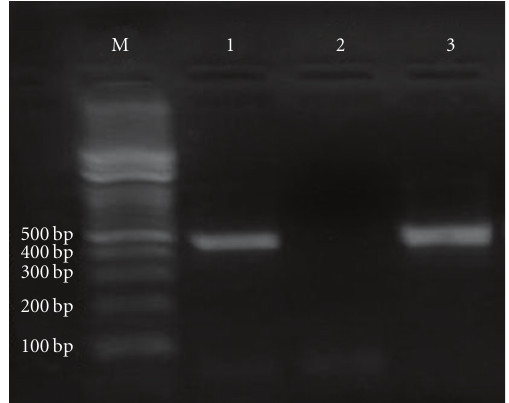
Figure 3: The 446 bp of amplification product of mt-CO1 with the JB3 and JB4.5 primers M: Marker, 1: Positive control (gDNA of an adult T. hydatigena ), 2: Negative control (distilled water), 3: Cystic sample collected from the